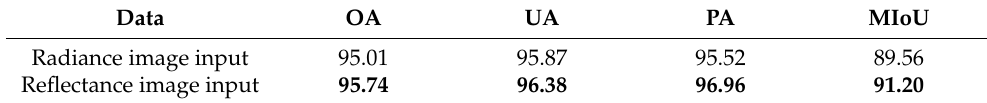
Table 7. The cloud detection accuracy (%) for evaluating reflectance image.